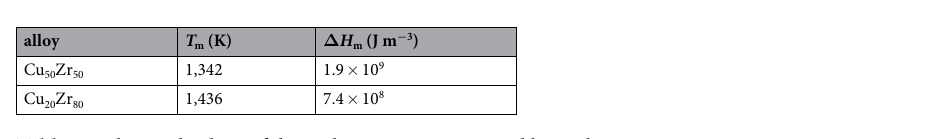
Table 1. Obtained values of the melting temperature and latent